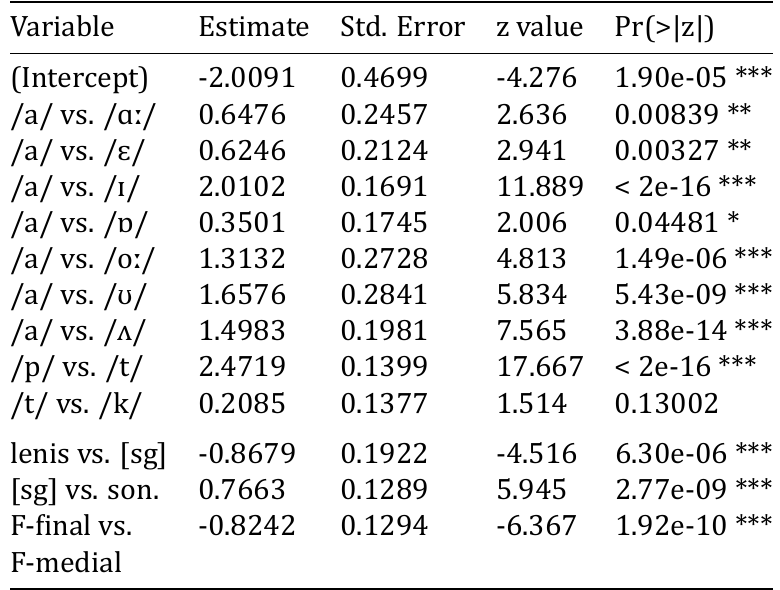
Table 1: Statistical results for the frequency of occurrence of pre-aspiration